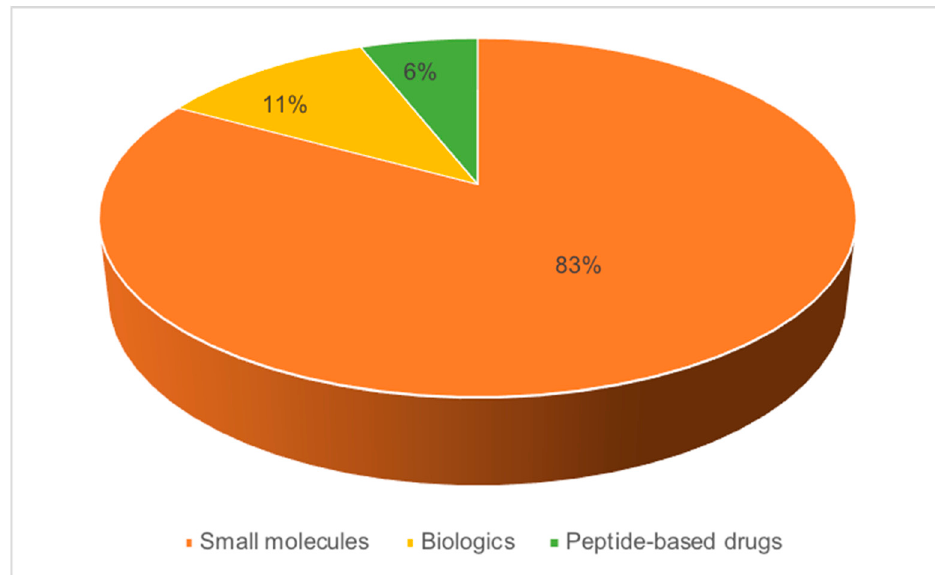
Figure 5. 2022-based global pharmaceutical market.